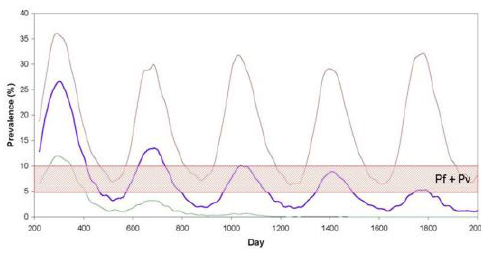
Figure 4. Simulated and observed malaria prevalence in a cluster of